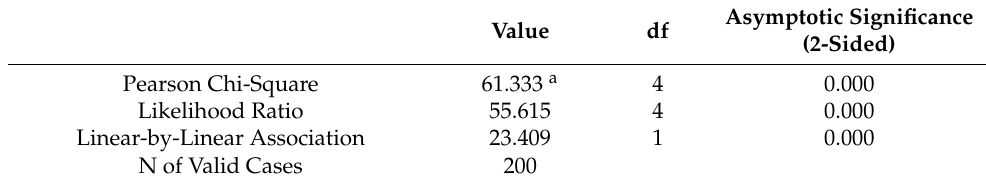
Table 4. Results of hypothesis 1 using the Chi-square